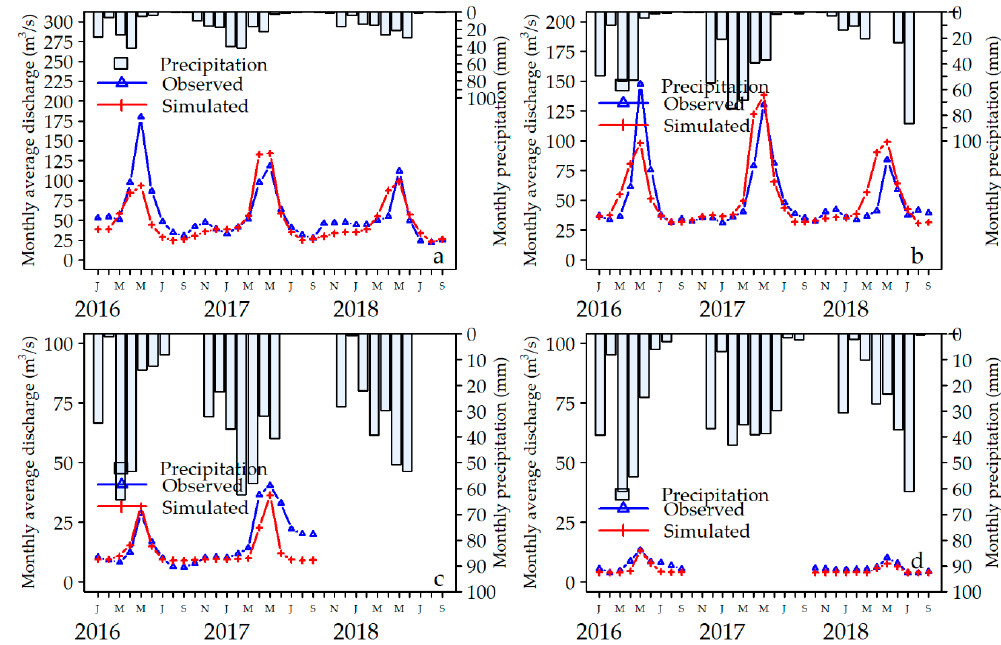
Figure 8. Comparison of the observed monthly average discharges with the simulated discharges for the model validation, in addition to the observed monthly precipitation for the validation period from 2016 to September 2018. ( a ) subbasin 7, ( b ) subbasin 10, ( c ) subbasin 28, and ( d ) subbasin 30.